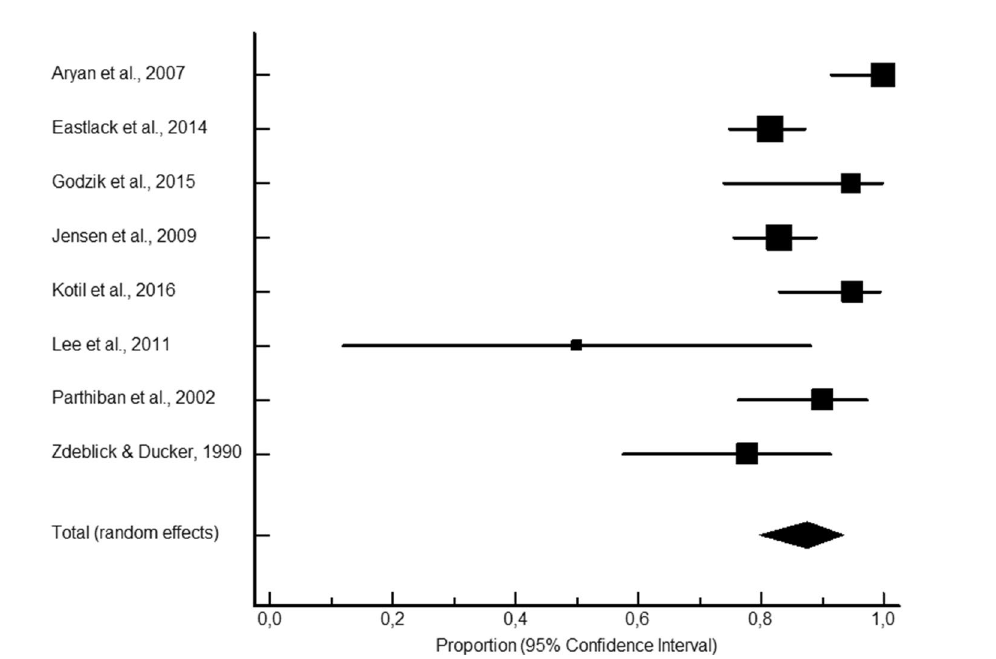
Figure 3. Allograft pooled proportional rate for spinal